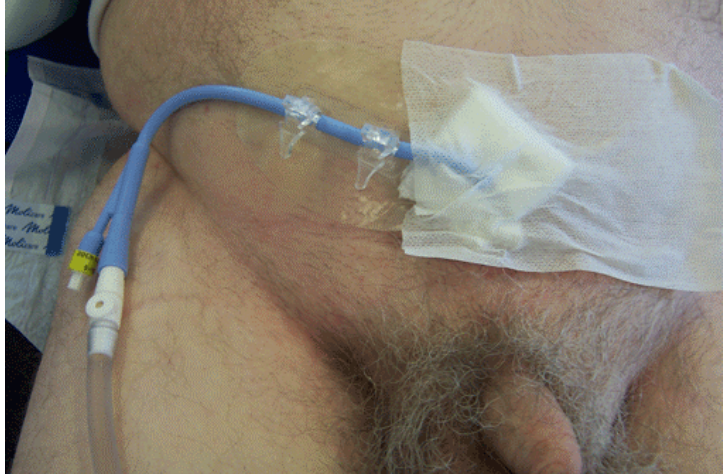
FIGURE 3 . Clinical photograph of the patient after applying BioDerm Tube Holder. A dressing and BioDerm Tube Holder hold the suprapubic catheter securely, thus preventing any traction on the Foley